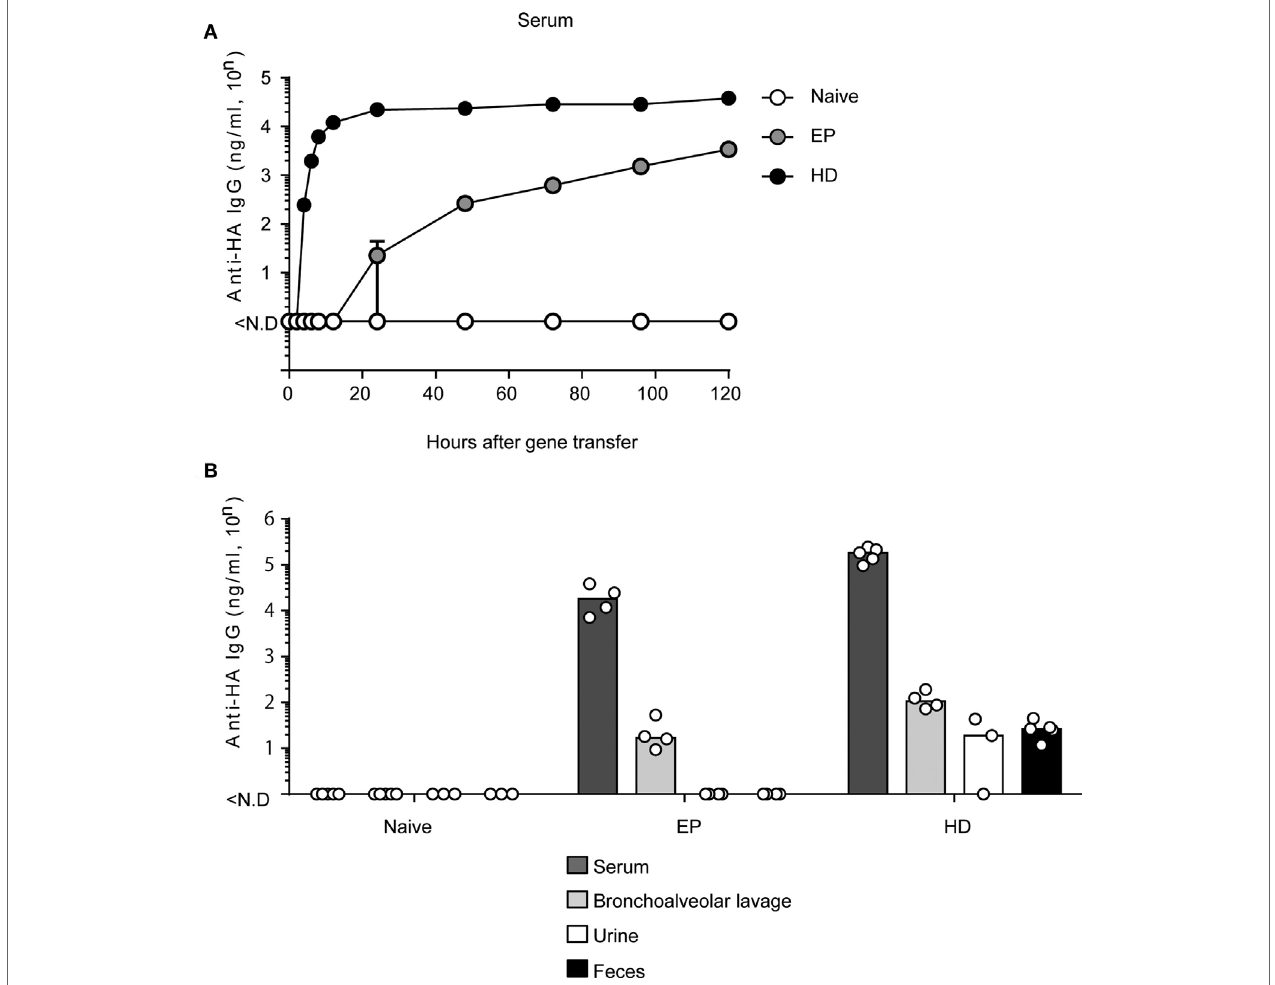
FigUre 1 | HD rapidly induces anti-HA neutralizing monoclonal antibody (mAb) in serum and in multiple mucosa. (a) Quantitative ELISA for neutralizing mAb in sera collected at indicated times after administration of the plasmid coding anti-HA IgG by electroporation (EP, n = 3) and by hydrodynamics (HD, n = 5). The naïve group represents no treatment ( n = 5). Error bars represent the SEM. (B) Five days after HD or 20 days after EP, the serum (Naïve, n = 5, EP, n = 4, HD, n = 5), bronchoalveolar lavage without serum contamination ( n = 5, n = 4, n = 4), urine ( n = 3, n = 4, n = 3), and fecal ( n = 3, n = 4, n = 5) specimens were obtained and subjected to quantitative ELISA. Each bar represents the median. The detection limit was over 46 ng/ml (serum) or 0.96 ng/ml (others). Each bar represents the median. ND, not detected. The indicated data about HD are representative of two independent